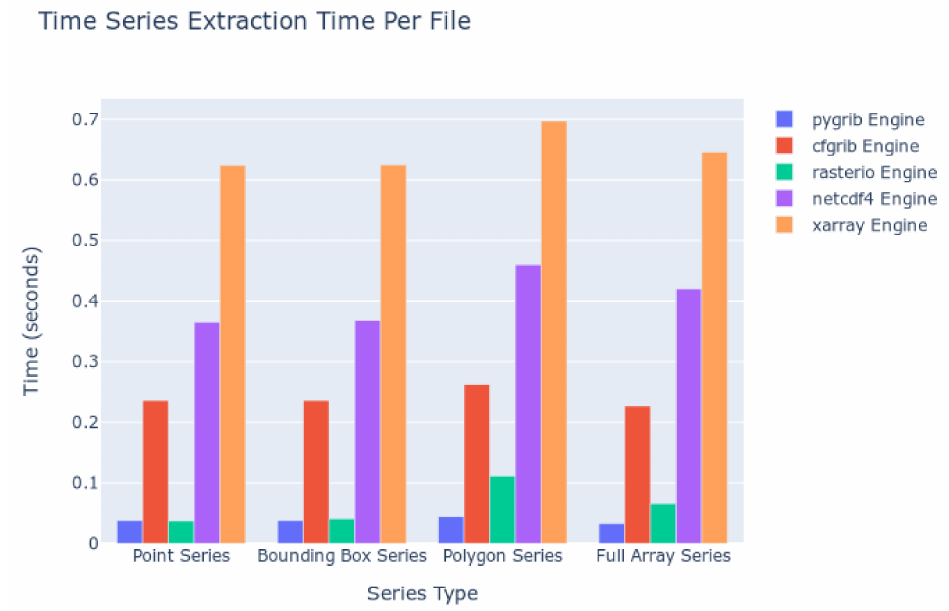
Figure 8. Time Series Extraction Time on Local